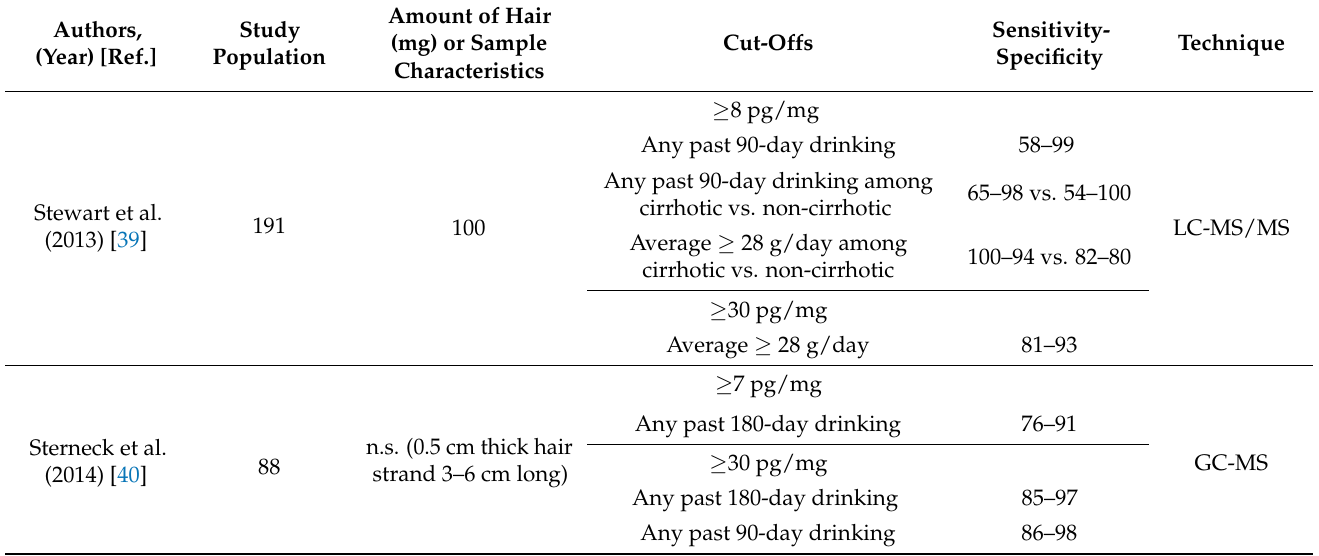
Table 1. Results of investigations carried out by different authors; the laboratory techniques, sensitiv- ity and specificity for each techique and respective